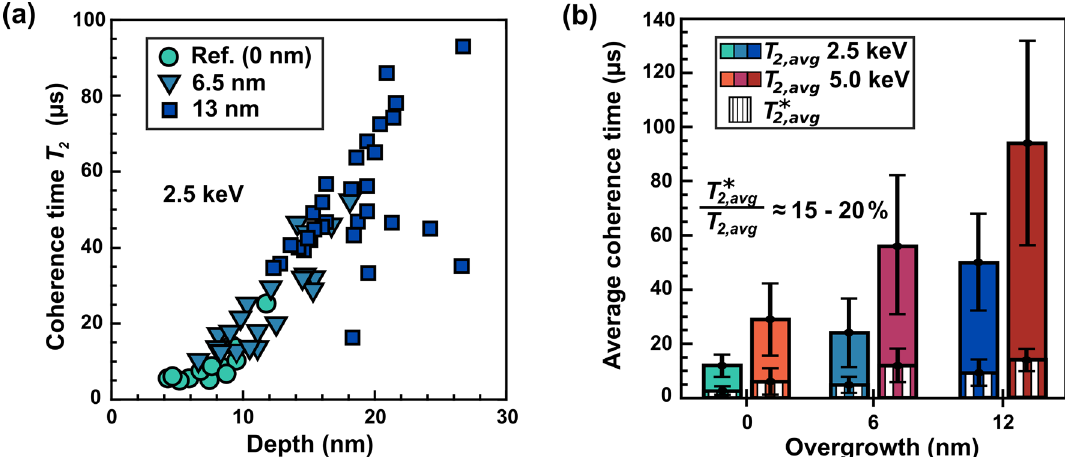
Figure 3. Enhancing the coherence time of single NV − centers by varying the thickness of the protective capping layer. ( a ) The scaling of T 2 (Hahn-echo) with depth for the reference and two capping-layer thicknesses, namely 6.5 nm and 13 nm. The values in the legend correspond to the layer thicknesses expected from the average growth rate in Fig. 2b. ( b ) Comparison of the average values for T 2, avg and T ∗ 2, avg and their evolution with the thickness of the overgrown layer for implantation energies of 2.5 keV and 5